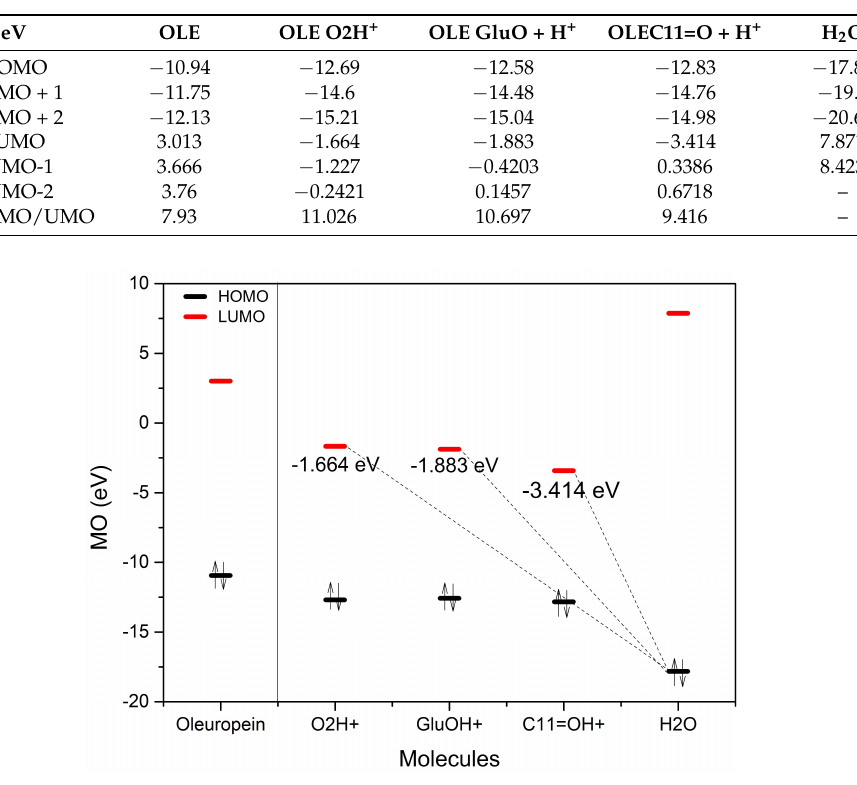
Figure 9. Oleuropein HOMO/LUMO and OLE + H + isomers and H 2 O correlation diagram of their FMO energies.